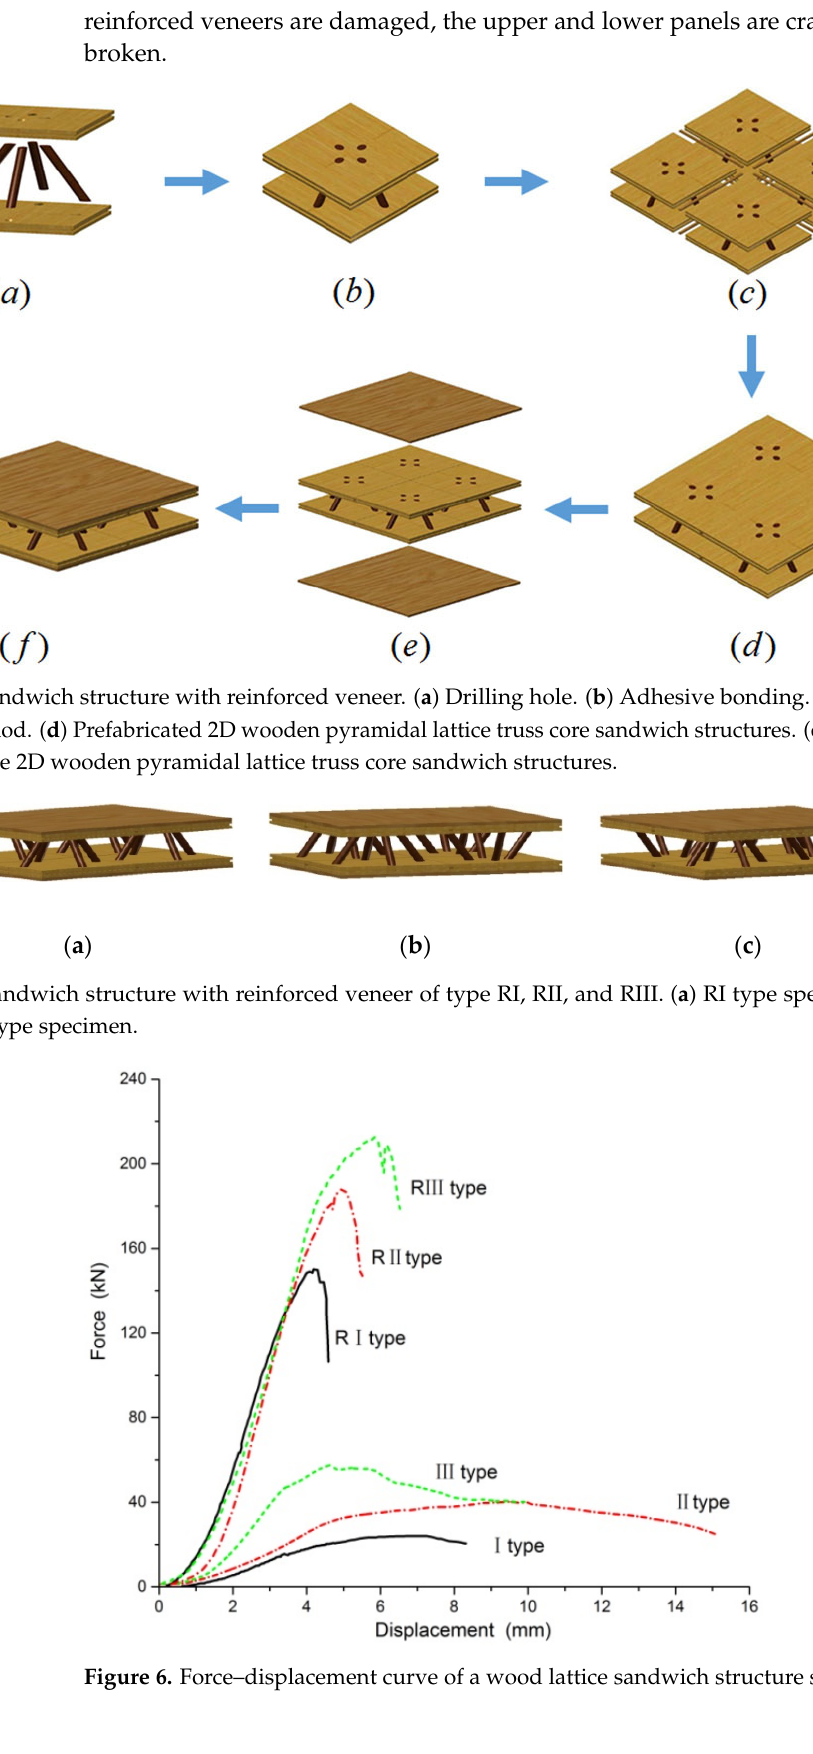
( c ) Figure 7. Failure modes of specimens with veneer reinforcement. ( a ) Failure of reinforced veneer. ( b ) Cracking of upper and lower panels. ( c ) Broken core. The analysis and comparison of six specimens (numbered I–III, RI–RIII) of the pre- fabricated 2D wooded pyramid lattice truss core sandwich structure are shown in Figure 8.